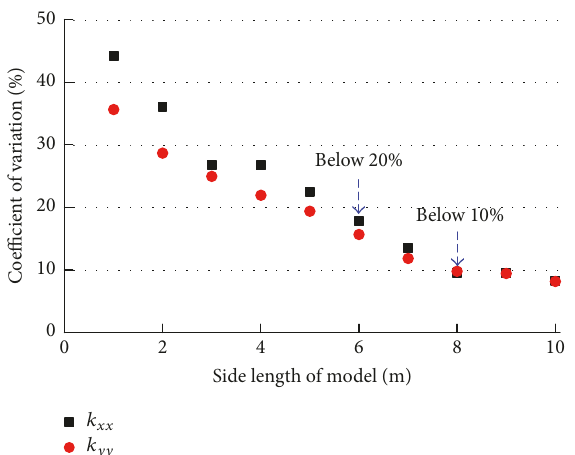
Figure 25: The values of coefficients of variation of 𝑘 𝑥𝑥 and 𝑘 𝑦𝑦 with increasing side lengths in the non-Darcy